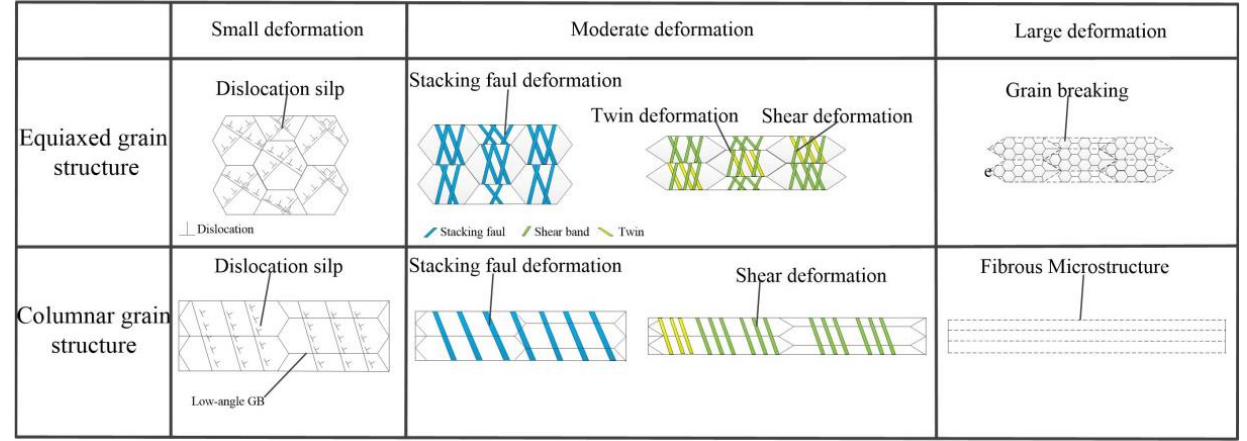
Figure 14. Deformation behavior of EG and CG strip during cold rolling.